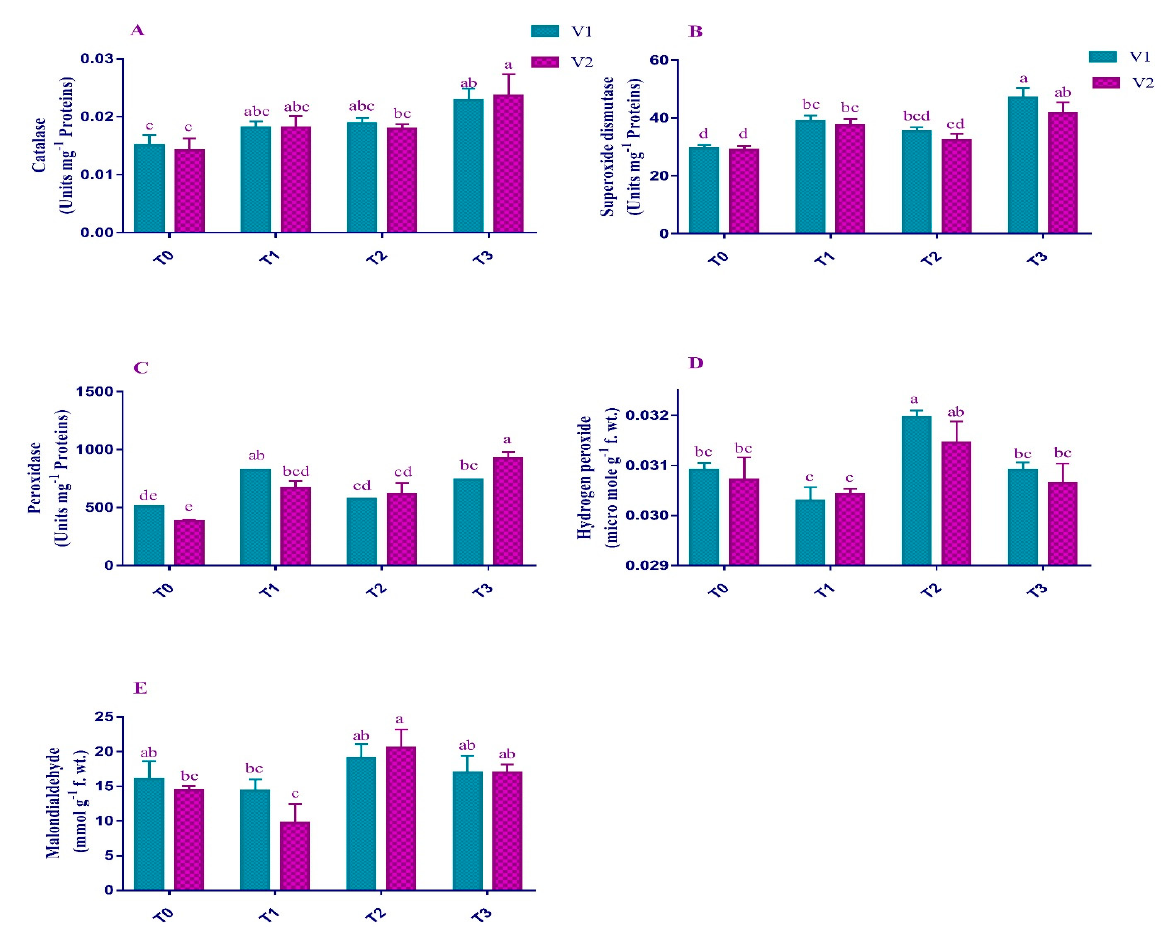
Figure 3. Effect of Pb and EDTA on ( A ) catalase (Units mg − 1 proteins), ( B ) superoxide dismutase (Units mg − 1 proteins), ( C ) peroxidase (Units mg − 1 proteins), ( D ) hydrogen peroxide (µmol g − 1 f. wt.), and ( E ) malondialdehyde (mmol g − 1 f. wt.) of brown mustard. Error bars above means indicate the ± SE of three replicates. Means sharing a letter for a parameter do not differ significantly at p ≤ 0.05. V1 = Faisal cultivar; V2 = Rohi cultivar; T 0 = 0 mM EDTA + 0 mM Lead acetate; T 1 = 2.5 mM EDTA + 0 mM Lead acetate; T 2 = 0 mM EDTA + 0.5 mM Lead acetate; T 3 = 2.5 mM EDTA + 0.5 mM Lead acetate.